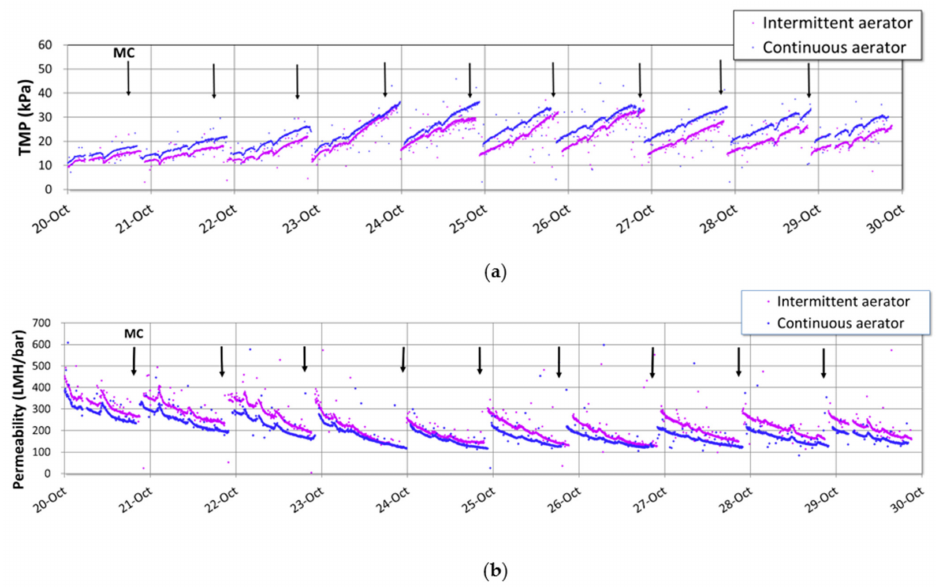
Figure 4. Comparison of aeration methods at a flux of 33 LMH: ( a ) TMP trend; ( b ) Permeability